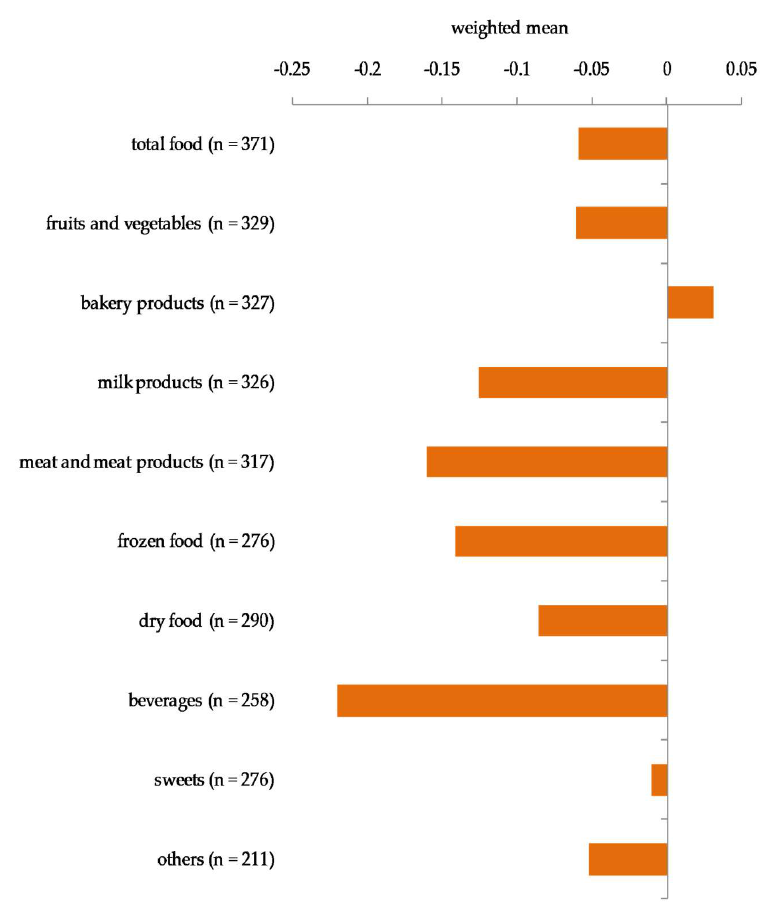
Figure 6. Weight of food distributed monthly by participating food banks in 2017 compared with 2016 on a five-point scale.